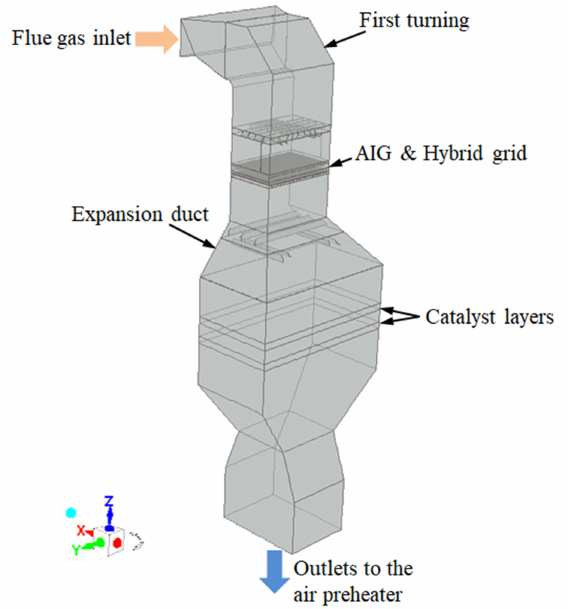
Figure 1. The schematic geometry of a tower type SCR-deNO x facility for a 1000 MW coal-fired power plant. AIG: Ammonia Injection